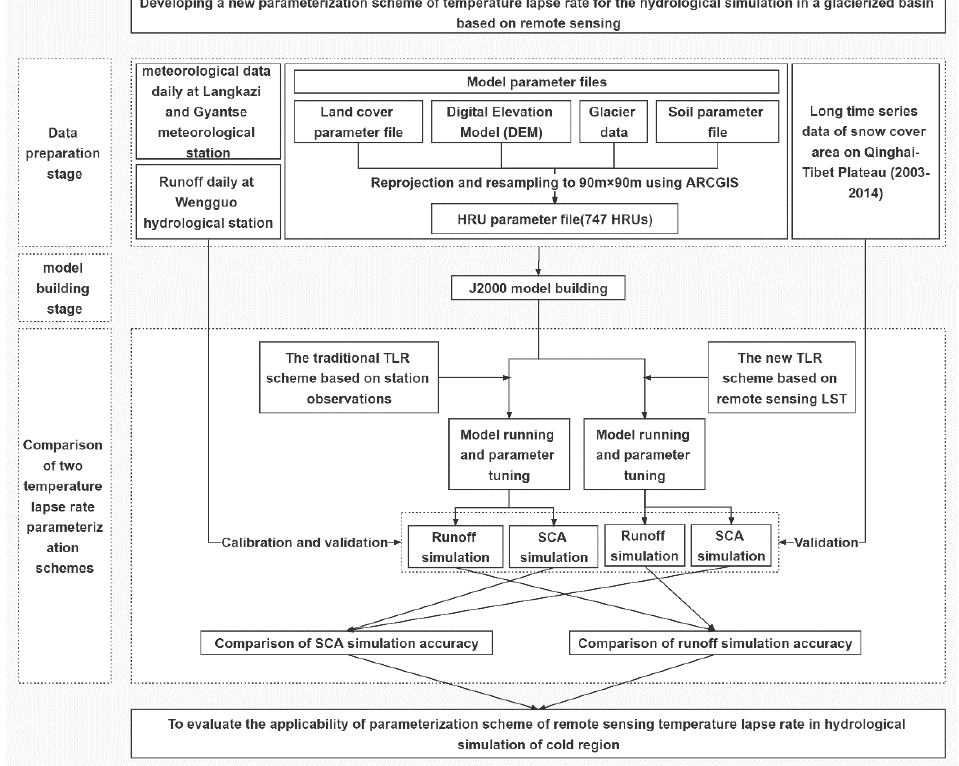
Figure 2. The flowchart of methods used in this study. “ HRU ” means hydrological response unit; “ SCA ” means snow cover area.